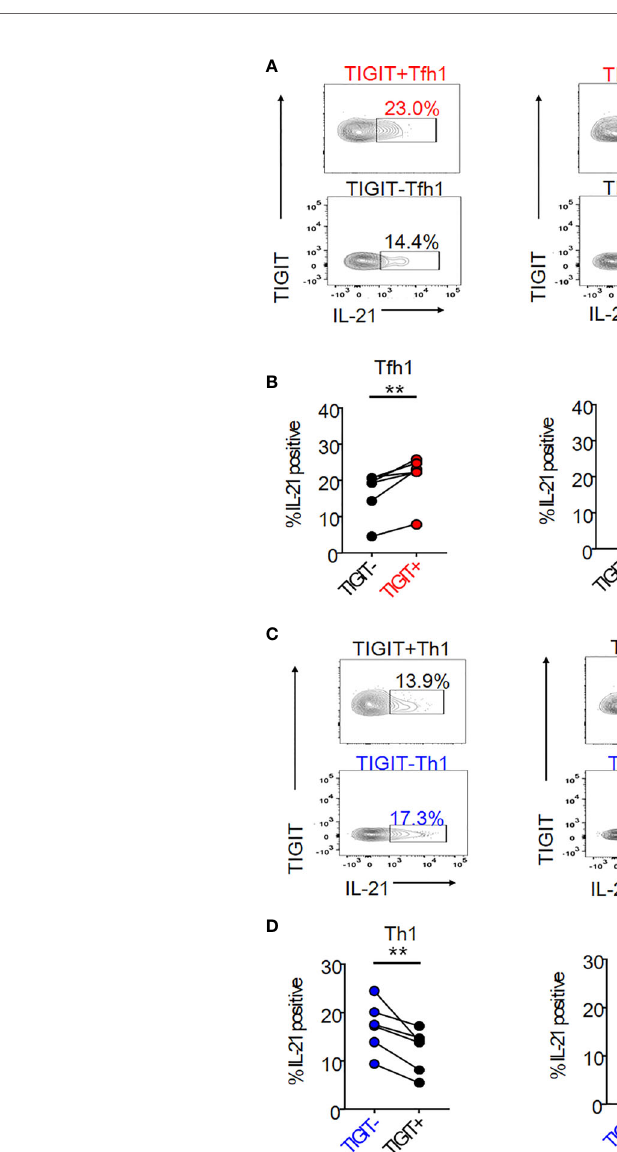
individuals (mean 70% versus 80%, p<0.001) ( Figure 7D ).